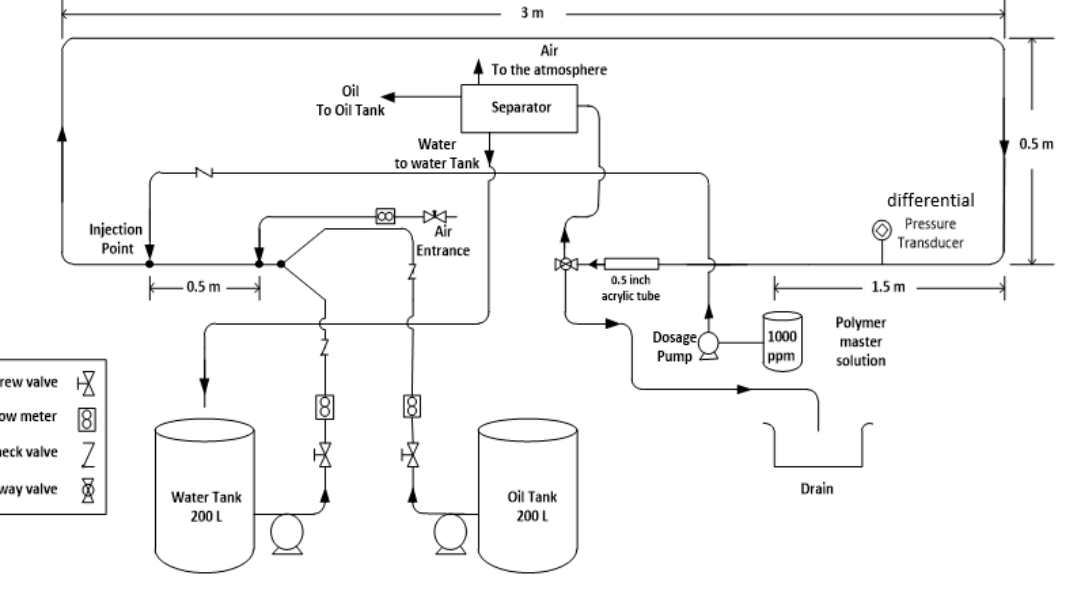
Figure 1. Sketch of the flow facility.